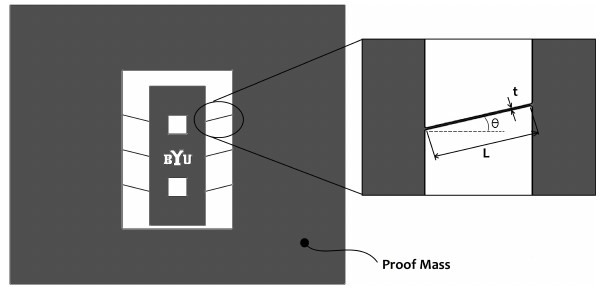
Figure 1. Bistable accelerometer design showing parameters that a ff ect bistability and force required for